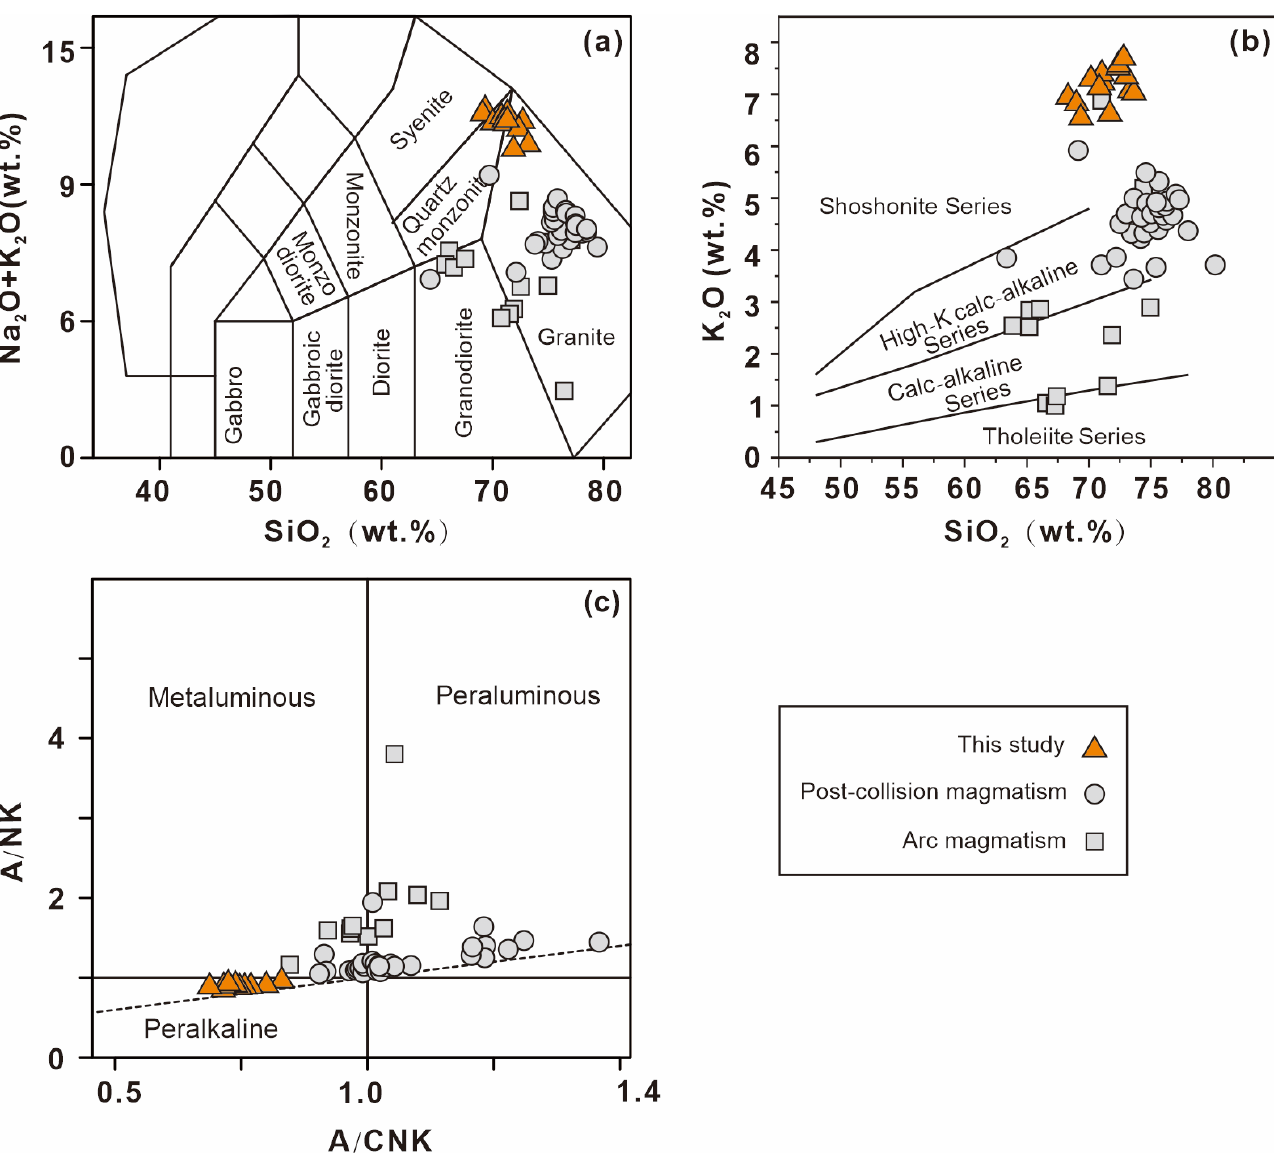
Figure 6. Major element diagrams for granitoids from the middle Huaniushan arc. ( a ) Na 2 O + K 2 O vs. SiO 2 diagram [62]; ( b ) SiO 2 vs. K 2 O diagram [63]; ( c ) A/NK vs. A/CNK diagram [64]. Geochemical data of post − collision and arc magmatism from [15,18,22–28].